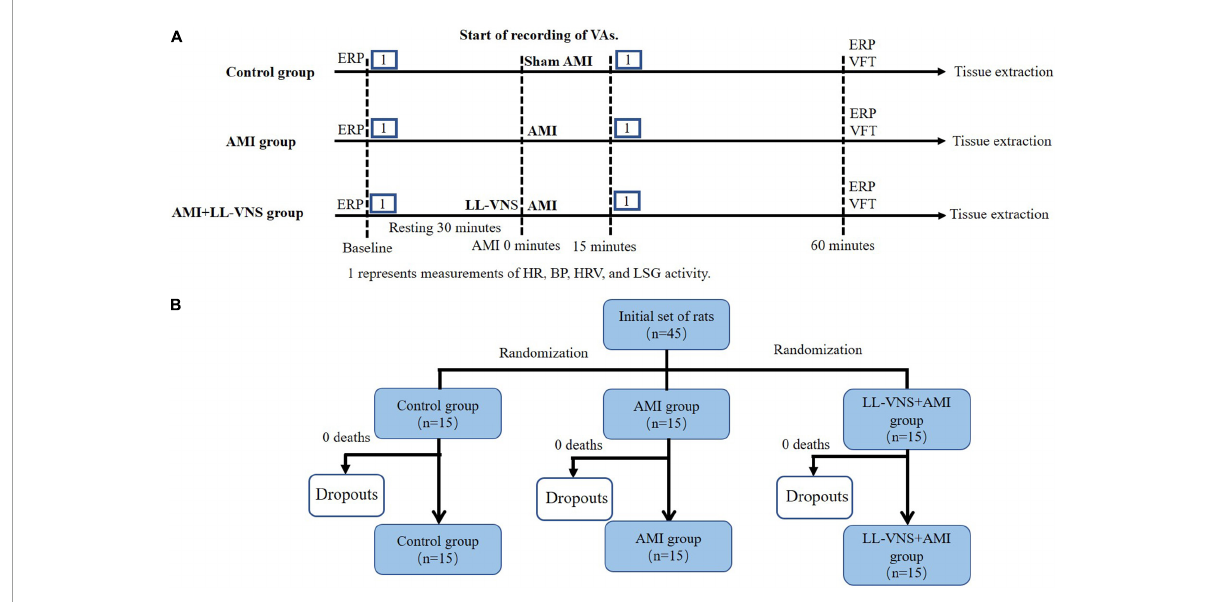
FIGURE1 The experimental protocol (A) and allocation to groups (B) . AMI, acute myocardial infarction; BP, blood pressure; ERP, effective refractory period; HR, heart rate; HRV, heart rate variability; LL-VNS, low-level vagus nerve stimulation; LSG, left stellate ganglion.